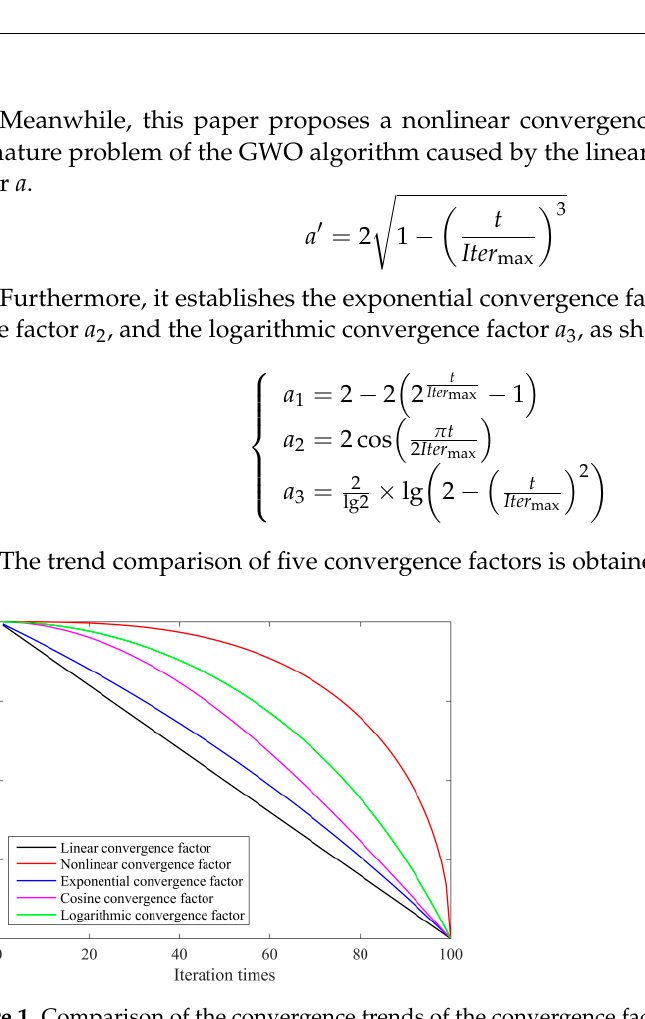
Figure 1. Comparison of the convergence trends of the convergence factors.